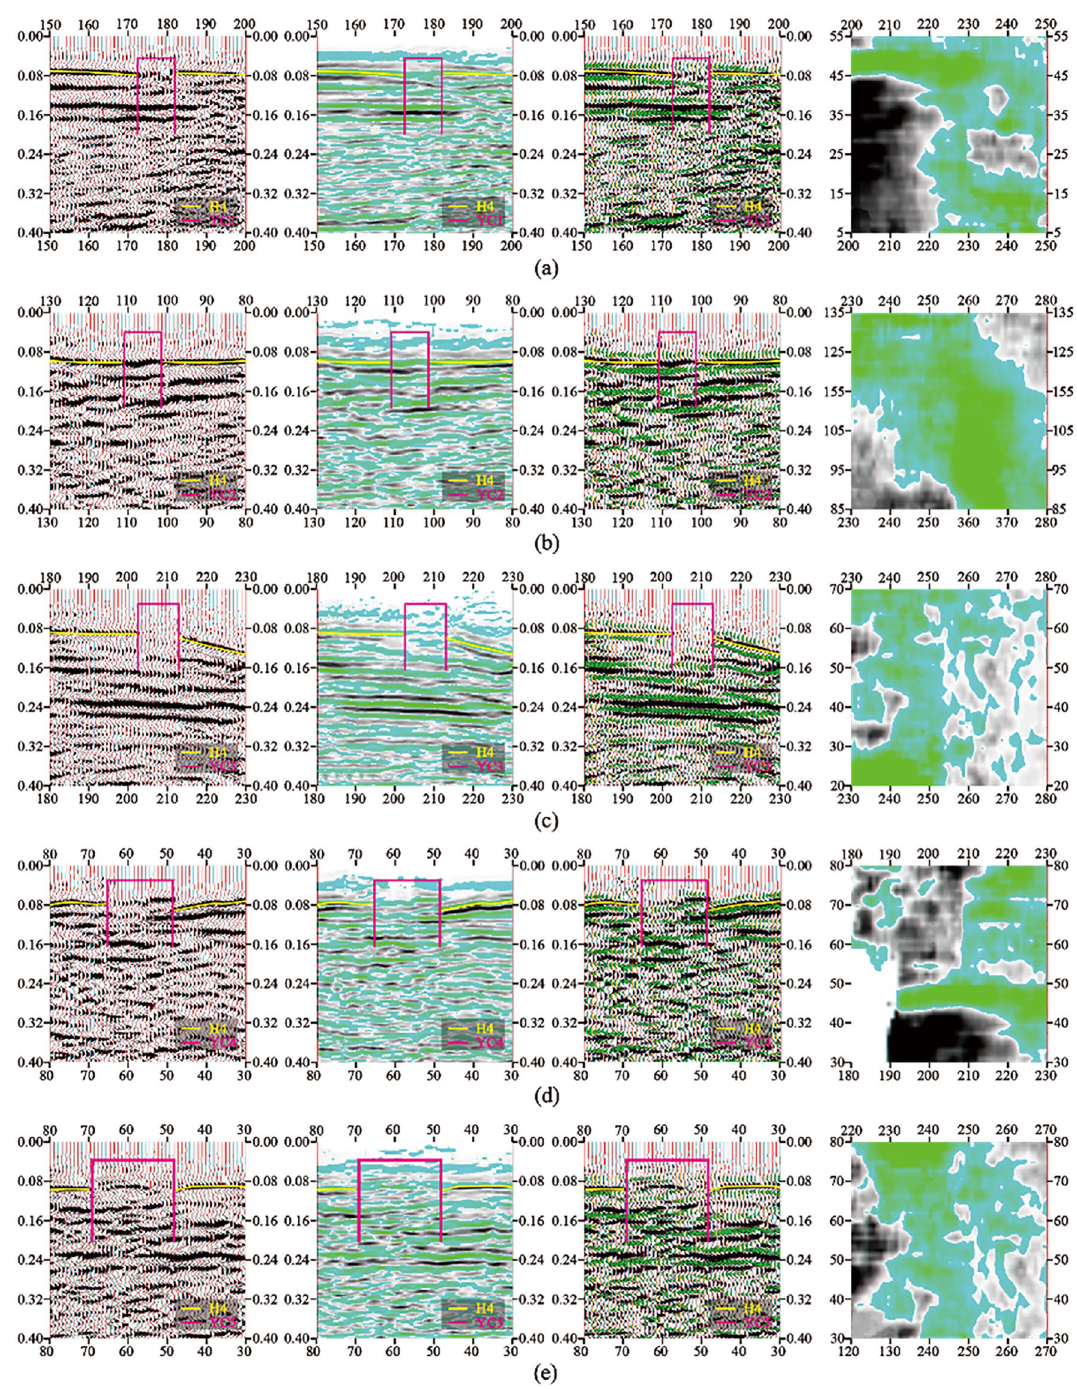
Figure 7. Schematic diagram of interpretation of suspected goaf (3D seismic exploration analysis and detection equipment): ( a ) YC1 comprehensive interpretation schematic diagram; ( b ) YC2 comprehensive interpretation schematic diagram; ( c ) YC3 comprehensive interpretation schematic diagram; ( d ) YC4 comprehensive interpretation schematic diagram; ( e ) YC5 comprehensive interpretation schematic diagram; ( f ) YC6 comprehensive interpretation schematic diagram; ( g ) YC7 comprehensive interpretation schematic diagram; ( h ) YC8 comprehensive interpretation schematic diagram; ( i ) YC9 comprehensive interpretation schematic diagram. compared with inferred mined-out areas, suspected mined-out areas are not clearly reflected in abnormal seismic time